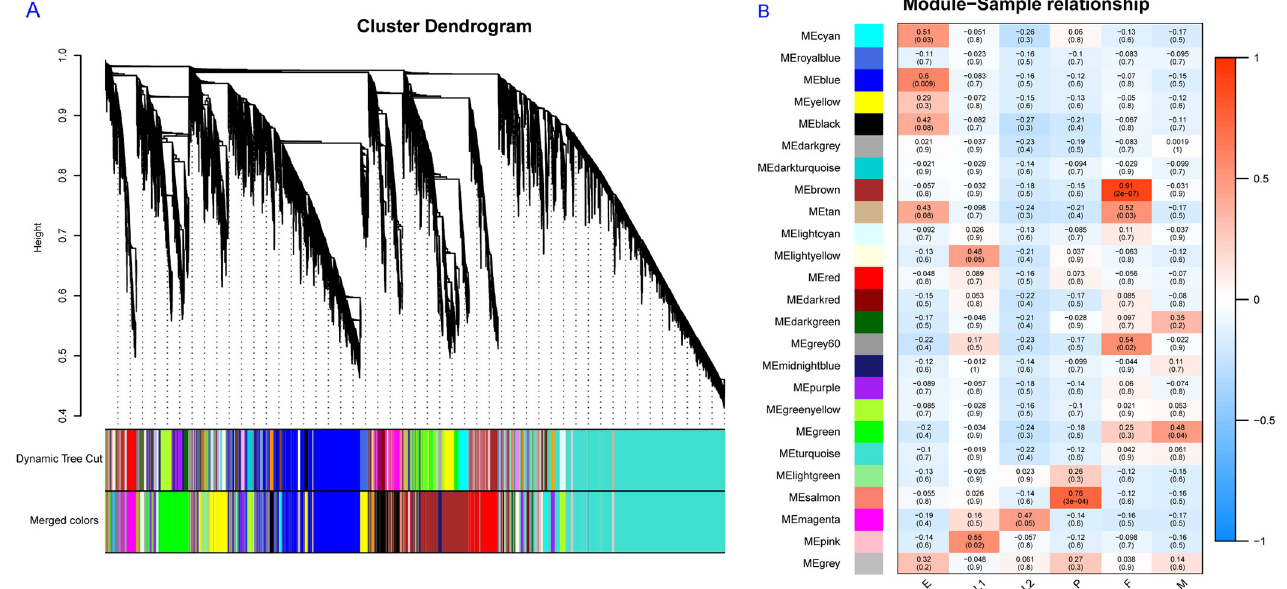
Fig 3. Gene modules identified by WGCNA. (A) Dendrogram of putative lncRNAs cluster obtained by hierarchical clustering, 25 modules were identified by different colors; (B) Module-trait relationships and corresponding p values. Each module was represented by one color on the left site of the heatmap. The color scale on the right shows module–trait correlation. Red indicated positive correlation (correlation > 0), whereas blue color indicated negative correlation (correlation < 0). E, egg; L1, early larvae; L2, late larvae; P, pupae; F, female; M, male.